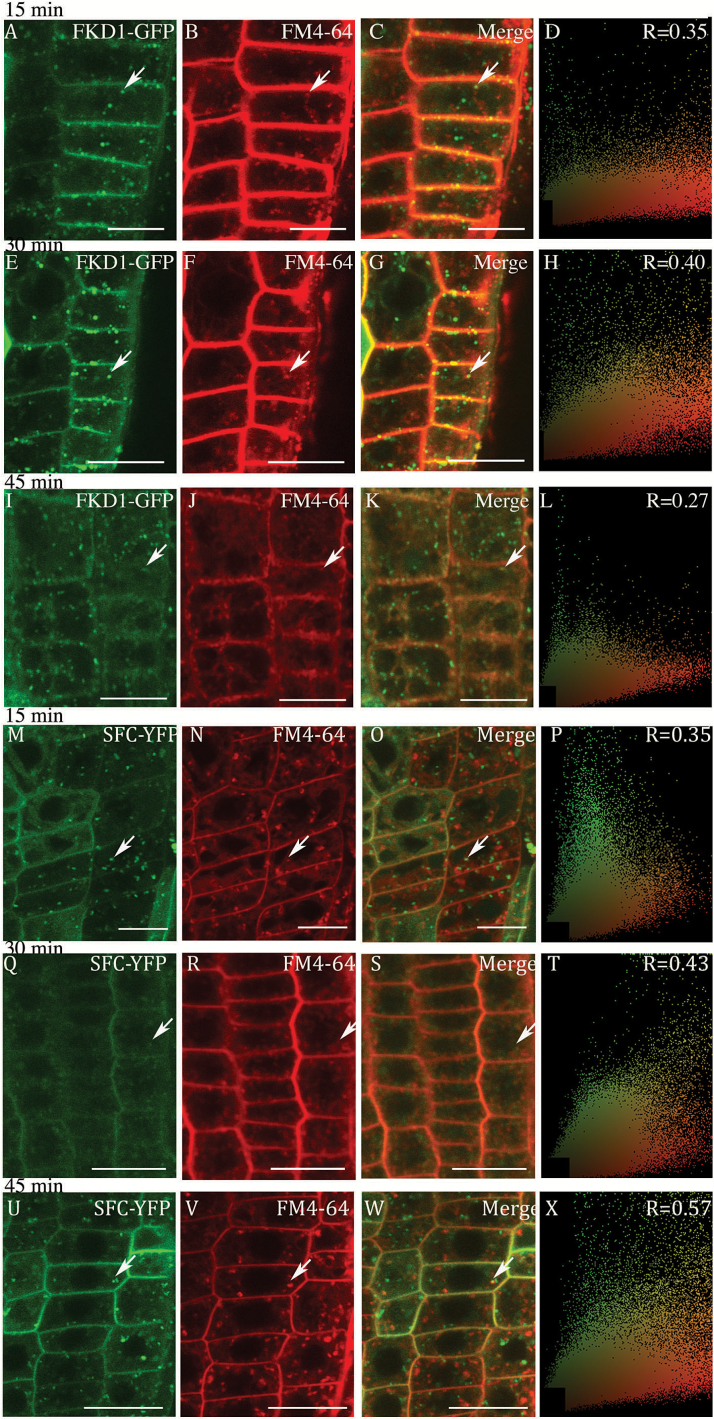
Co-localization of 35S:FKD1–GFP or 35S:SFC–YFP with FM4-64 at different time intervals. Epidermal ells in the root elongation zone expressing 35S:FKD1–GFP (A–L) or 35S:SFC–YFP (K–X) stained with the endocytic tracer FM4-64 after 15 min (A–D; M–P), 30 min (E–H; Q–T), and 45 min (I–L; U–X). (A), (E), and (I) 35S:FKD1–GFP alone; (M), (Q), and (U) 35S:SFC–YFP alone; (B), (F), (J), (N), (R), and (V) FM4-64 alone; (C), (G), (K), (O), (S), and (W) merged images; (D), (H), (L), (P), (T), and (X) scatter plots of the merged image with Pearson’s coefficient of correlation (R) values. Arrows indicate punctae labeled by both FKD1–GFP or SFC–YFP and FM4–64. Scale bars=10 μm.